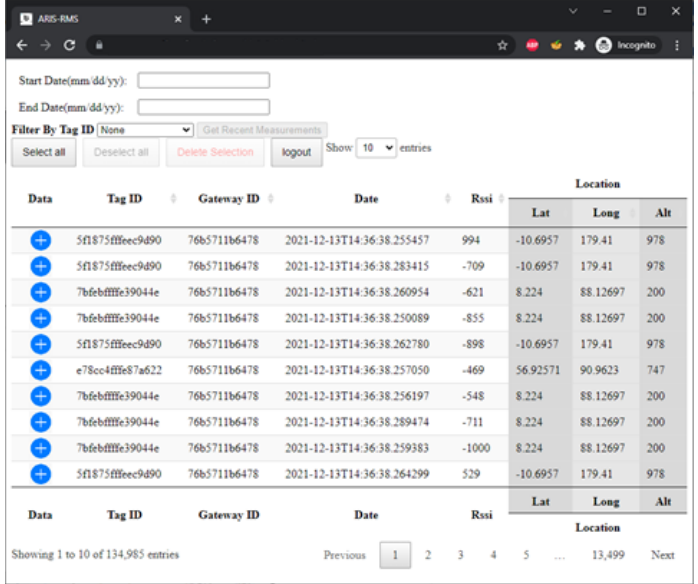
Figure 3. CRUD Manager